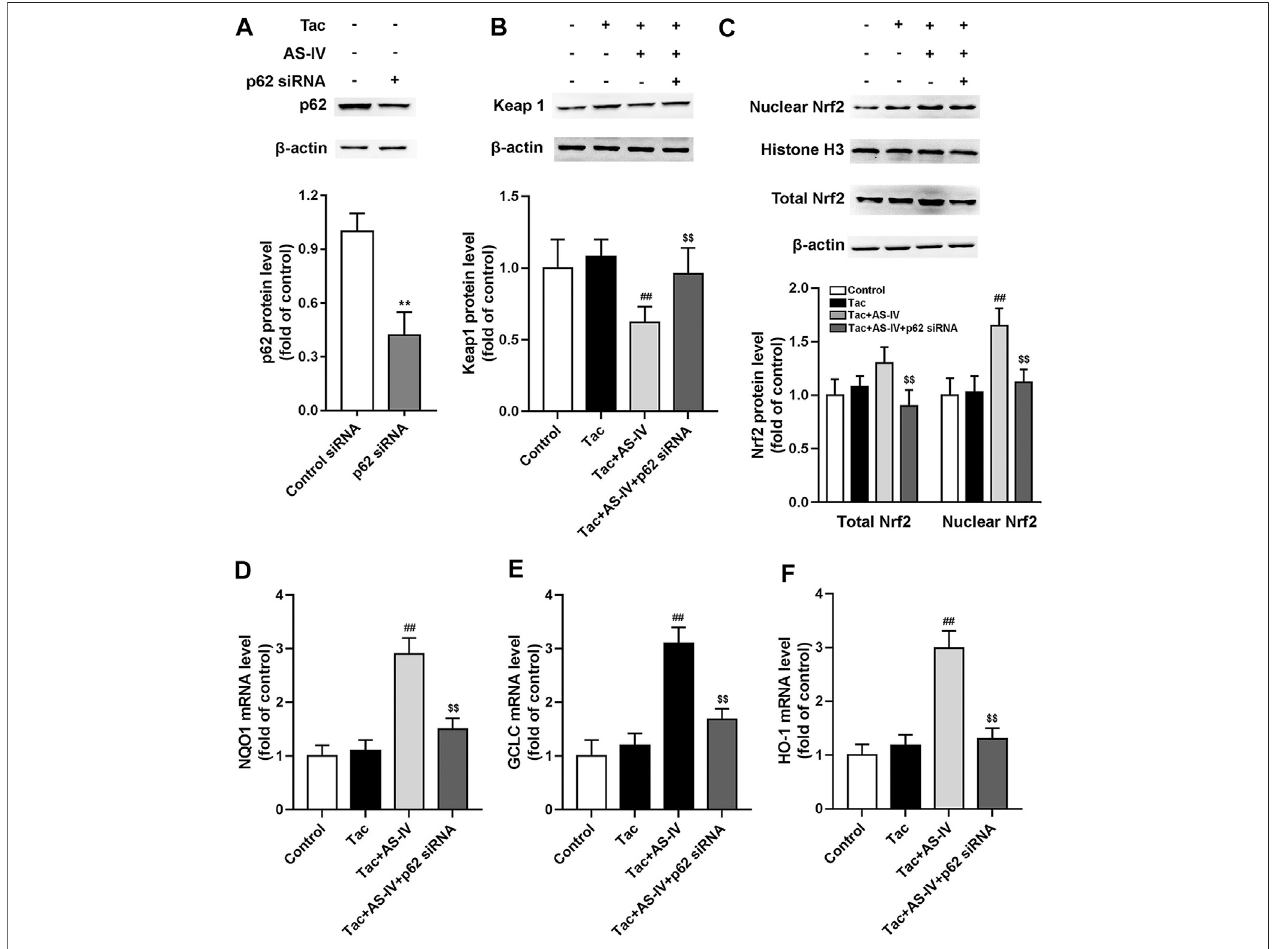
FIGURE 7 | p62 siRNA inhibited Astragaloside IV-induced Nrf2 nuclear translocation and down-stream genes transcription in HK-2 cells via p62-Keap1-Nrf2 pathway.TheHK-2cellsweretransfectedwithunconjugatedcontrolsiRNAorp62siRNA,andthentheproteinlevelsofp62( n (cid:1) 4) (A) ,Keap1( n (cid:1) 6) (B) ,andthenuclear Nrf2aswellastotalNrf2( n (cid:1) 6) (C) weredetected.ThemRNAlevelsofNQO1 (D) ,GCLC (E) andHO-1 (F) ,wereevaluatedbyRT-qPCR( n (cid:1) 8).** p < 0.01vs.theControl group; ## p < 0.01 vs. the Tac group; $$ p < 0.01 vs. the Tac + AS-IV group.